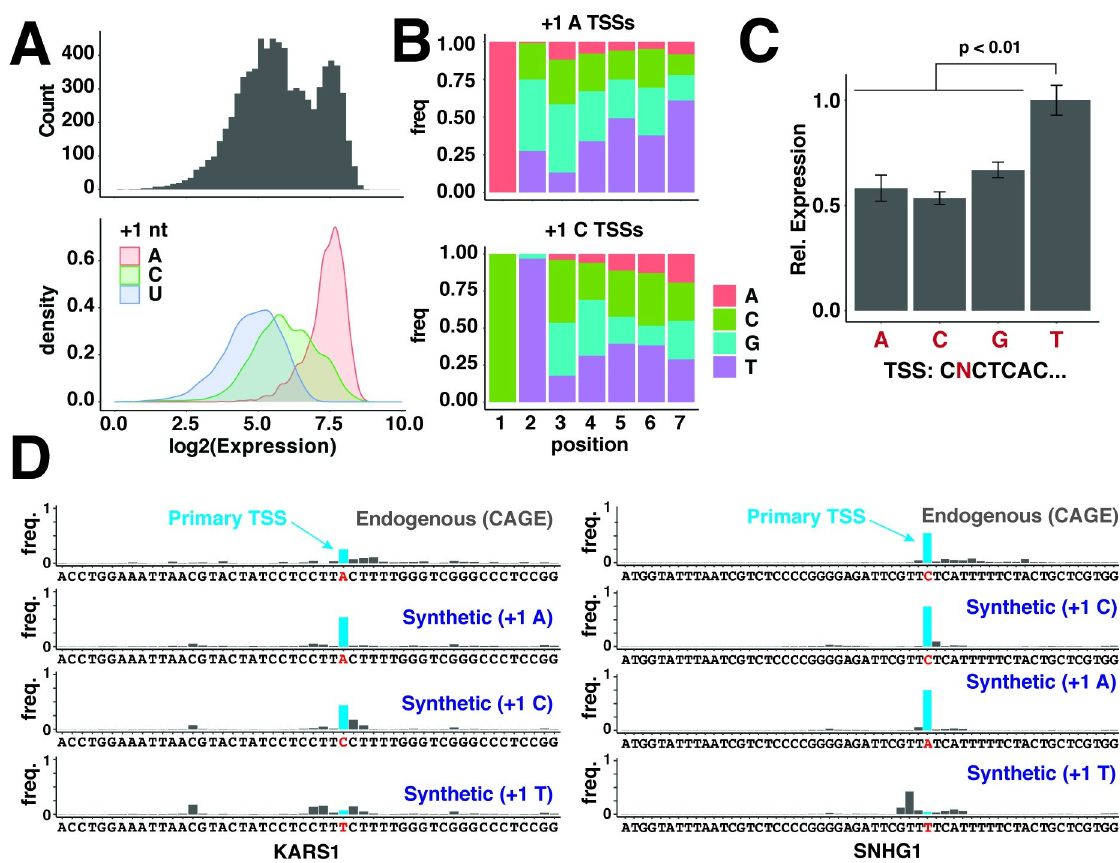
Fig 2. mRNA 5 0 sequences strongly impact expression level. (A) Expression levels of 5pseq library mRNAs. Library mRNAs were expressed in HeLa cells, extracted, and used to prepare sequencing libraries. Frequencies of all 7 nt sequences initiating with A, C or U were determined and normalized to frequencies within the input plasmid library. Library mRNAs were then binned by expression level and plotted as a histogram (upper panel) or density plot separately depicting expression levels of mRNAs initiating with the indicated nucleotide (lower panel). (B) Motifs in 5 0 sequences of well-expressed +1 A and +1 C mRNAs. Nucleotide frequencies within the first 7 nucleotides of the top 5% +1 A and +1 C library mRNAs from (A). (C) The +2 U is required for maximal expression of +1 C mRNAs. Plasmids expressing mRNAs encoding Renilla luciferase and initiating with the indicated 5 0 sequences were transfected into HEK-293T cells. Expression levels of each mRNA were determined 24 h later by qPCR. Significance by t-test between +2 U and each other construct, n = 3. (D) The TSS +1 nucleotide impacts initiation efficiency in endogenous core promoters. TSS frequencies for endogenous KARS1 and SNHG1 genes in HeLa cells (FANTOM5) or from synthetic core promoter regions of KARS1 or SNHG1 where the expected +1 nucleotide is an A, C or T.